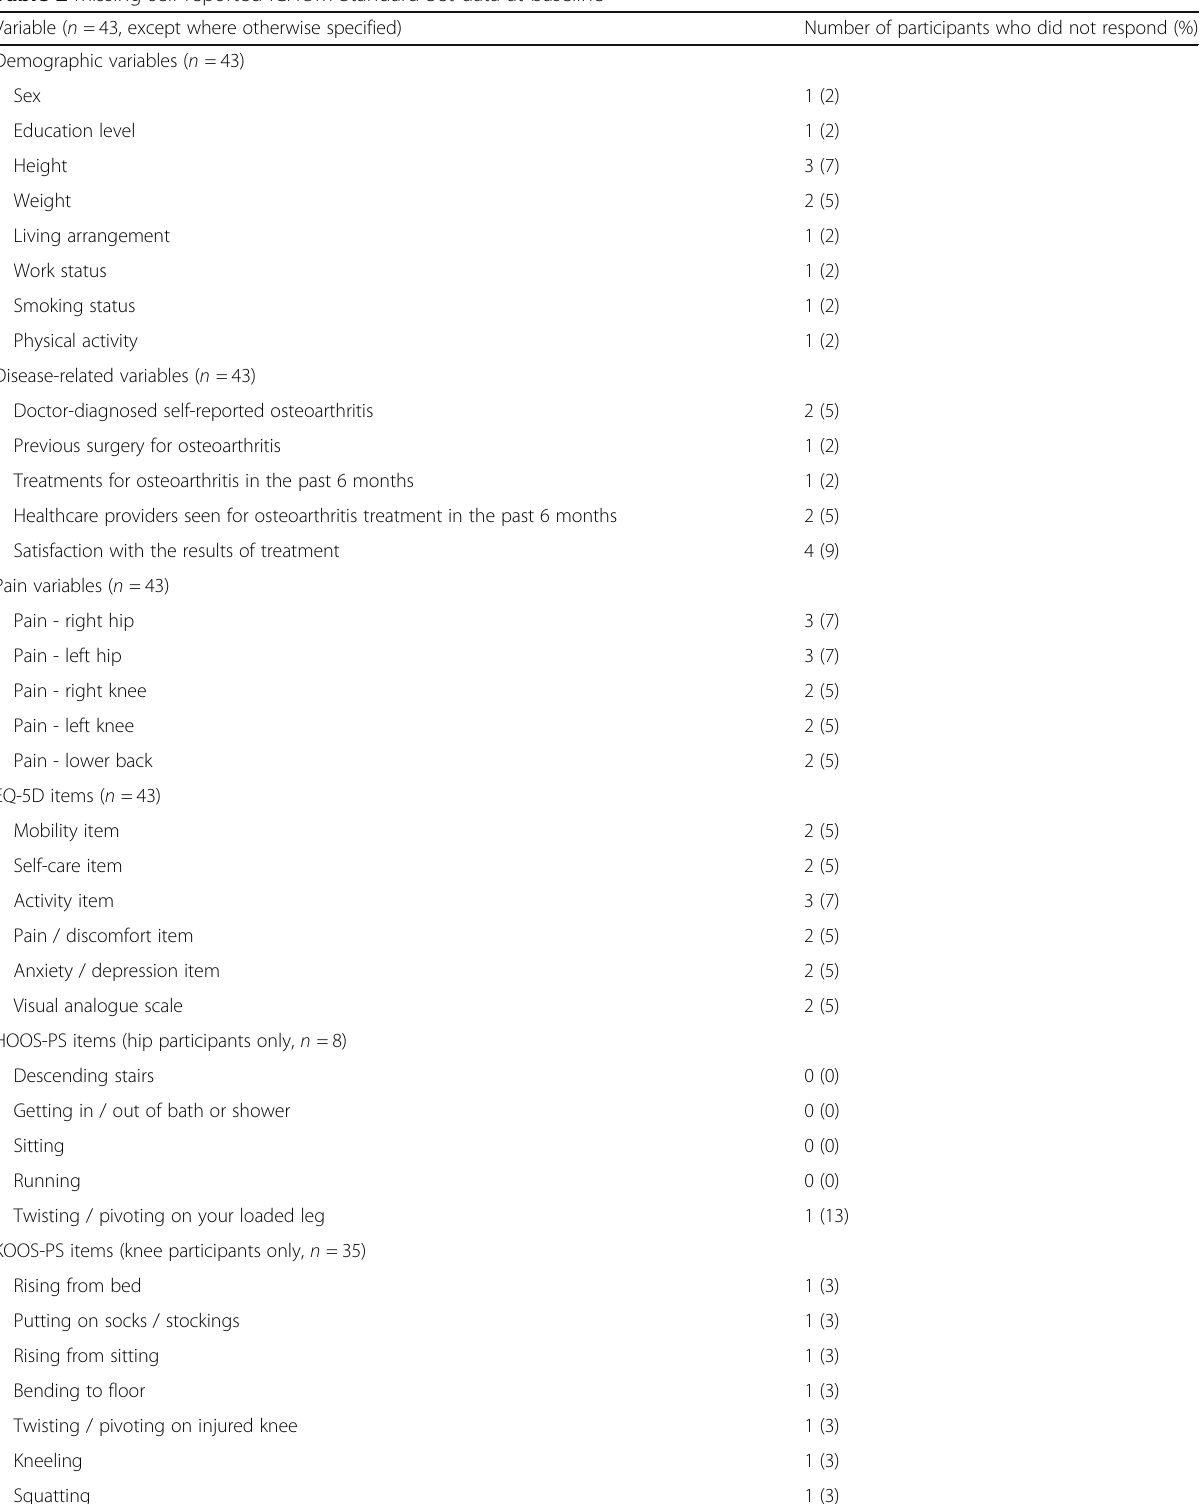
Table 2 Missing self-reported ICHOM Standard Set data at baseline Variable ( n = 43, except where otherwise specified) Number of participants who did not respond